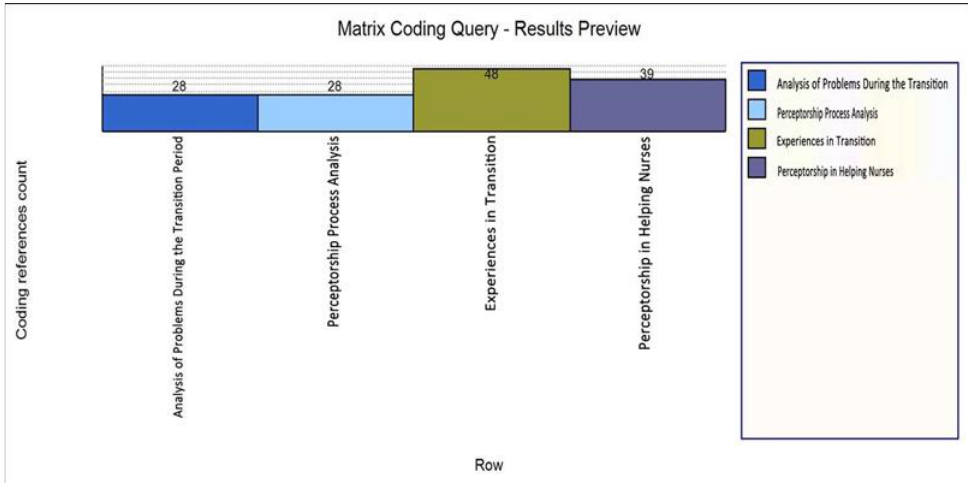
Fig. 12. Themes with